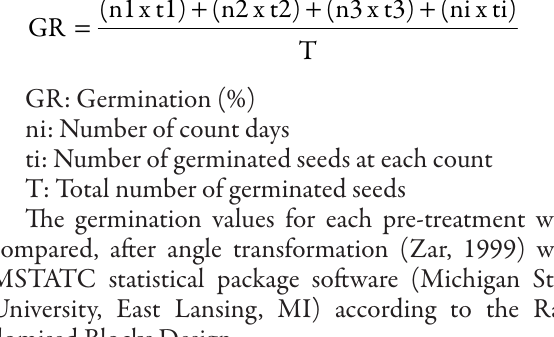
Tab. 1. The effect of different temperatures and durations on germination rates of black locust ( Robinia pseudoacacia L.) seeds Black locust ( R. pseudoacacia L.)